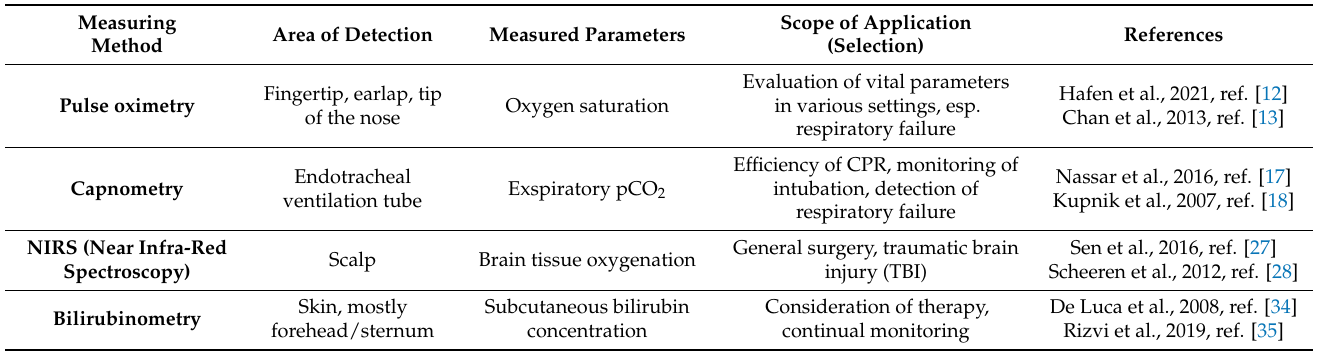
Table 1. Non-invasive